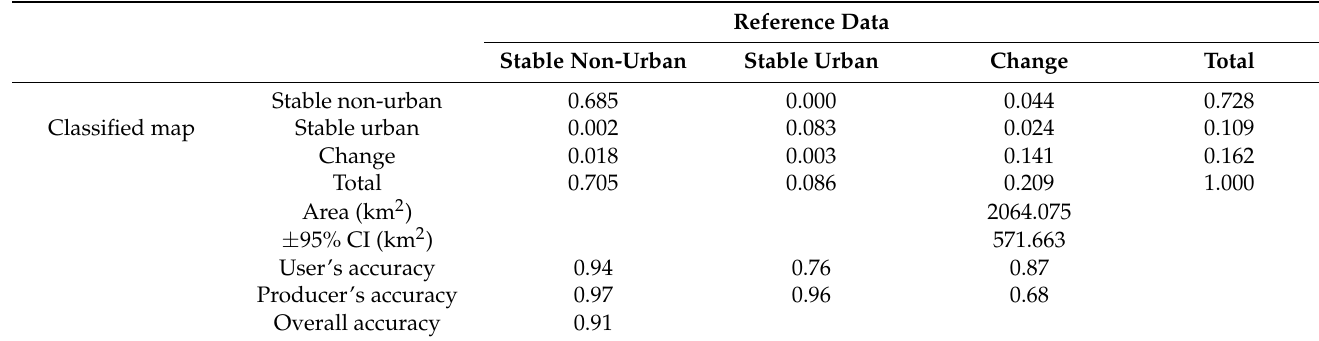
Table 2. Confusion matrix of the multi-temporal urban change map